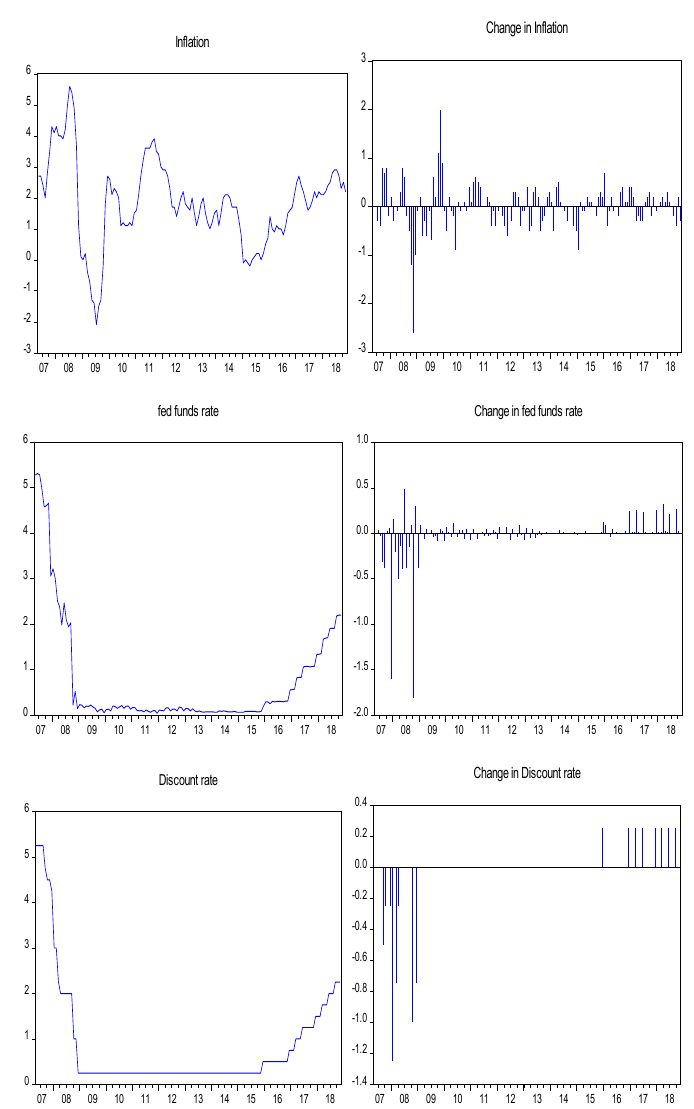
Figure 3. Time series volatility for industrial production index, inflation, federal funds rate and discount rate in levels ( left ) and returns ( right ) for the full sample between May 2007 and December 2018.